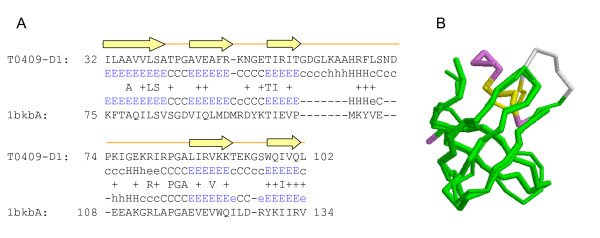
An example of the prediction results of the target T0409 from the (PS)2-v2 server. The alignment and predicted structure of the BIG_1156.2 domain of putative penicillin-binding protein MrcA from Nitrosomonas europaea ATCC 19718 using the (PS)2-v2 server. (A) The alignment between the query and the selected template, translation initiation factor 5A protein (PDB code 1bkbA), from Pyrobaculum aerophilum. (B) The superposition, the native structure of T0409 (broad, PDB code 3d0f) and the predicted structure (thin). The green blocks are the regions that the predicted structure matches to the native structure. The yellow and purple blocks indicate the shift errors between predicted structure and native structure, the Cα distances between them are <5 Å and >5 Å, respectively.